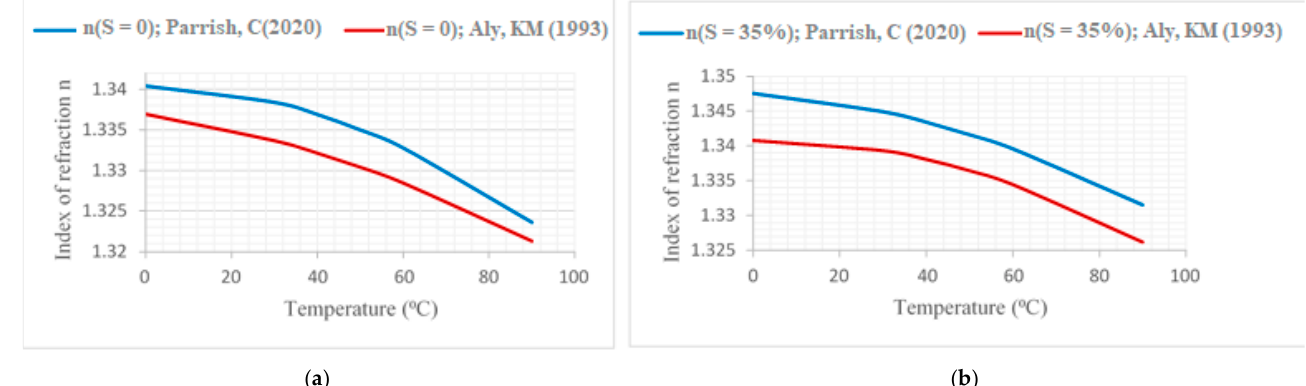
Figure 2. Refractive index 𝑛 (cid:3050) vs. Temperature for ( a ) pure water with 𝑆 = 0 ; ( b ) salt water with 𝑆 = 35% using two different methods (Parrish, C [56] and Aly, KM [46]).